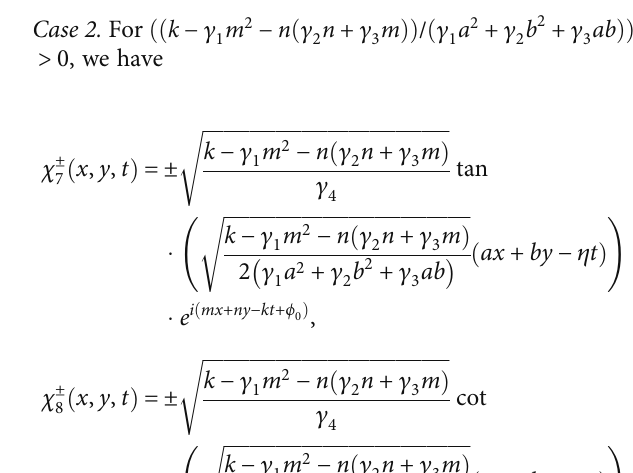
Figure 1: The behavior of j χ + (a) The 3-D plot for t = 0 . (b) The 2-D curve for y = 0 and t = 0